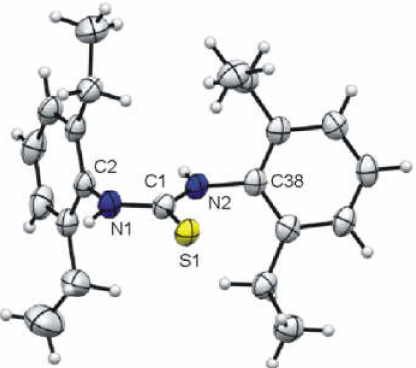
Figure 1. Molecular structure of 1,3-bis(2,6-diethylphenyl)thiourea ligand (ellipsoids correspond to